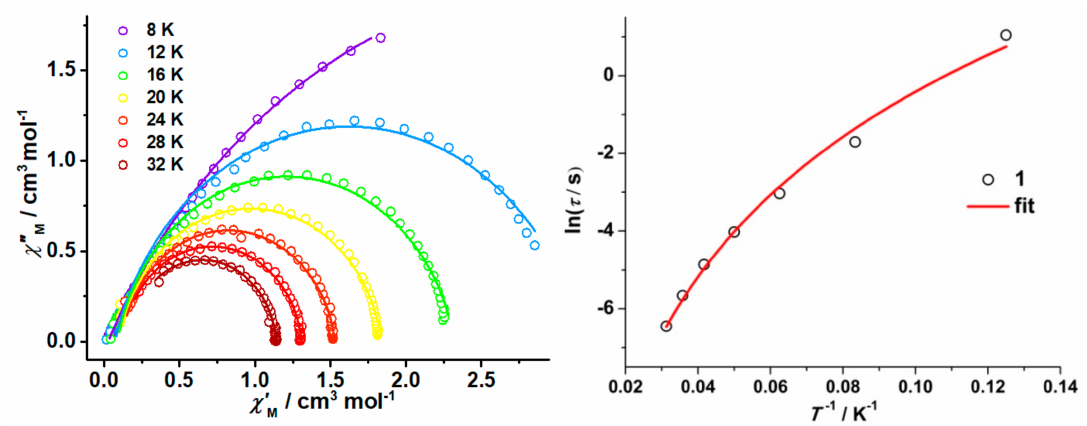
Figure 4. Cole–Cole data for Complex 1 . Solid curves are the fitting results from generalized Debye model ( left ); temperature dependence of magnetic relaxation time τ for 1 under 2000 Oe field. Solid line is the fit based on the Raman process ( right